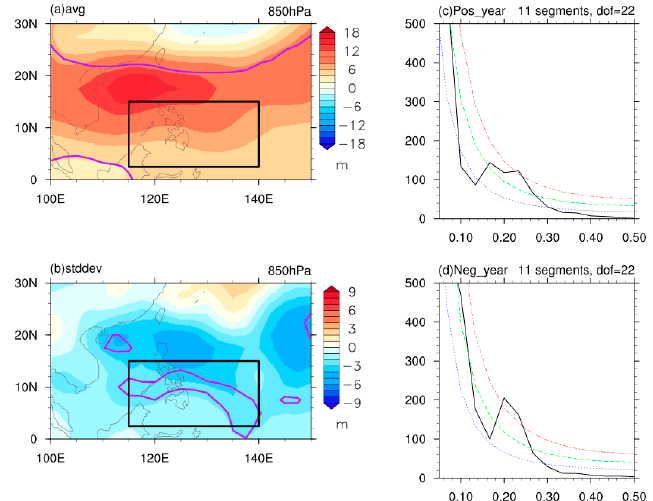
Figure 3. Difference in geopotential height at 850 hPa between Pos_year and Neg_year: ( a ) June mean geopotential height at 850 hPa; ( b ) standard deviation of synoptic geopotential height at 850 hPa; purple counters indicate p -value of 0.05; and ( c , d ) spectral analysis of geopotential height at 850 hPa for the black box in ( a , b ) for Pos_year and Neg_year, respectively. Green, blue and red dashed lines represent the red noise spectra, and its 0.95 and 0.05 confidence intervals, respectively.